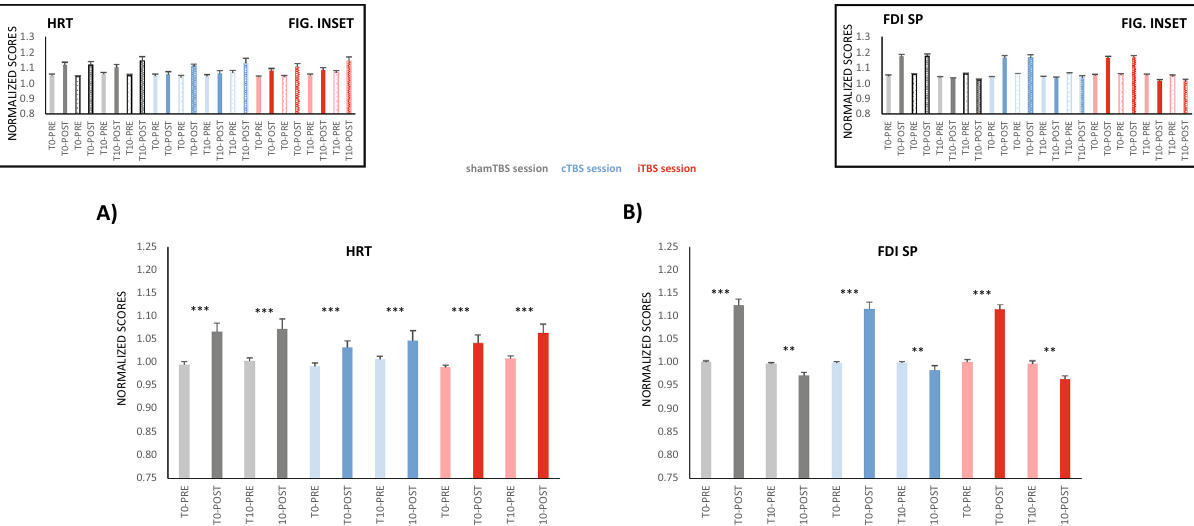
Figure 4. Effects of M1-TBS on HRT and FDI SP duration. ( A ) HRT and ( B ) FDI SP show results by pooling those from the ischaemia condition since ischaemia as a main effect was not significant and did not have any significant interactions with other factors. For both variables, the responses of cTBS and iTBS did not differ significantly from those observed for shamTBS. HRT increased significantly at POST (both T0 and T10). SP was significantly increased POST FT only for T0 and reduced at T10, and this did not differ across different TBS sessions. The insets indicate responses for HRT and SP before and after FT in the delay and ischaemia conditions for the three TBS protocols (solid bars = no ischaemia, textured bars = ischaemia); asterisks denoting significance were omitted as the effects were not different from the pooled responses in ( A ) and ( B ). **p ≤ 0.01, ***p ≤ 0.001. The y-axis unit score values are shown in Table